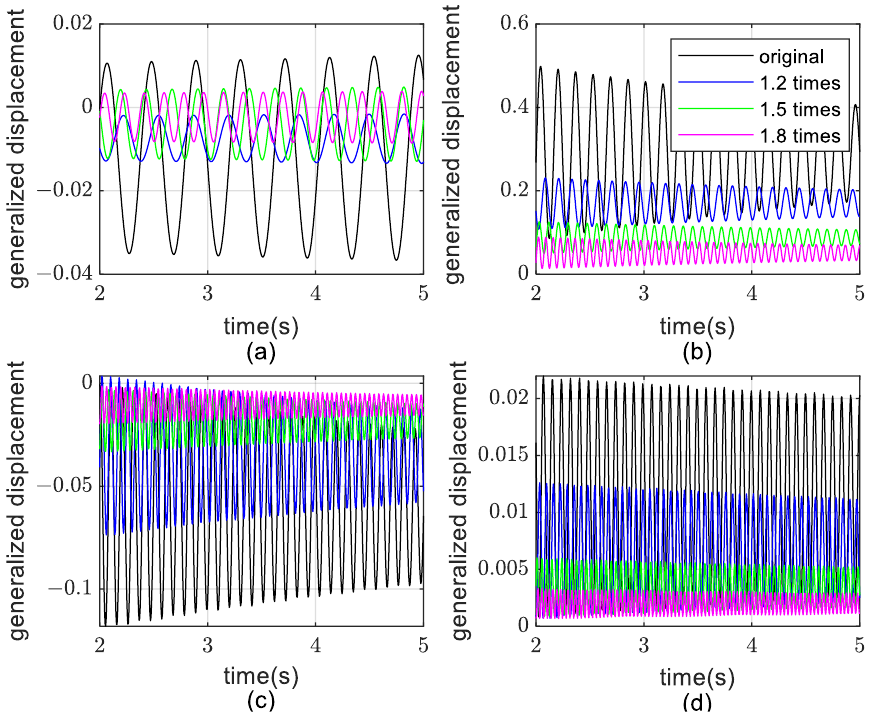
Figure 22. Curves of the generalized displacement time–response with shells of different